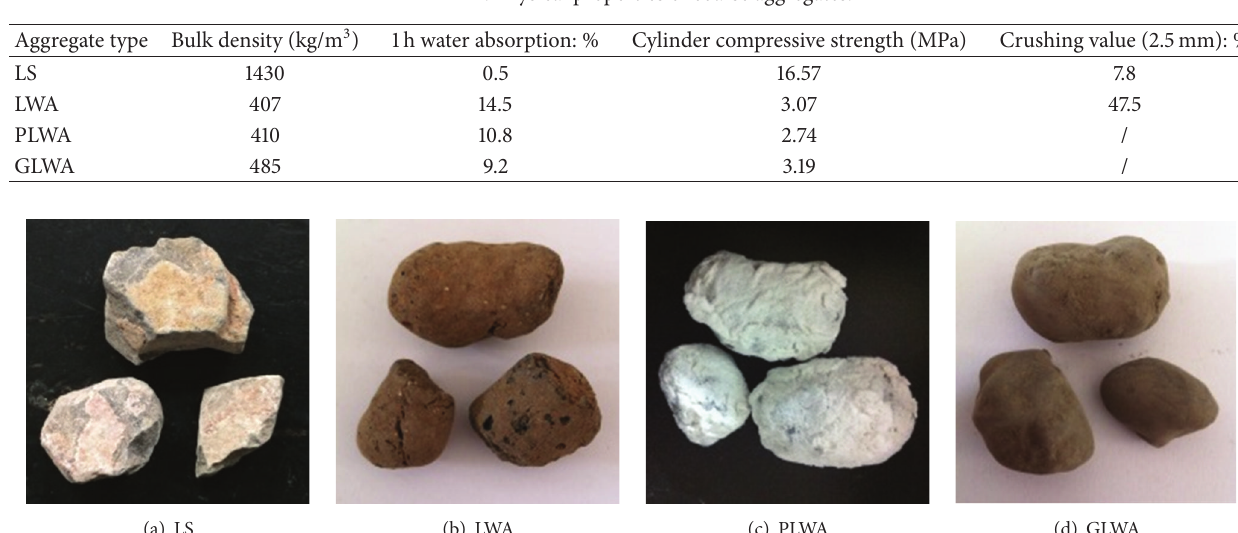
Table 2: Physical properties of coarse aggregates.